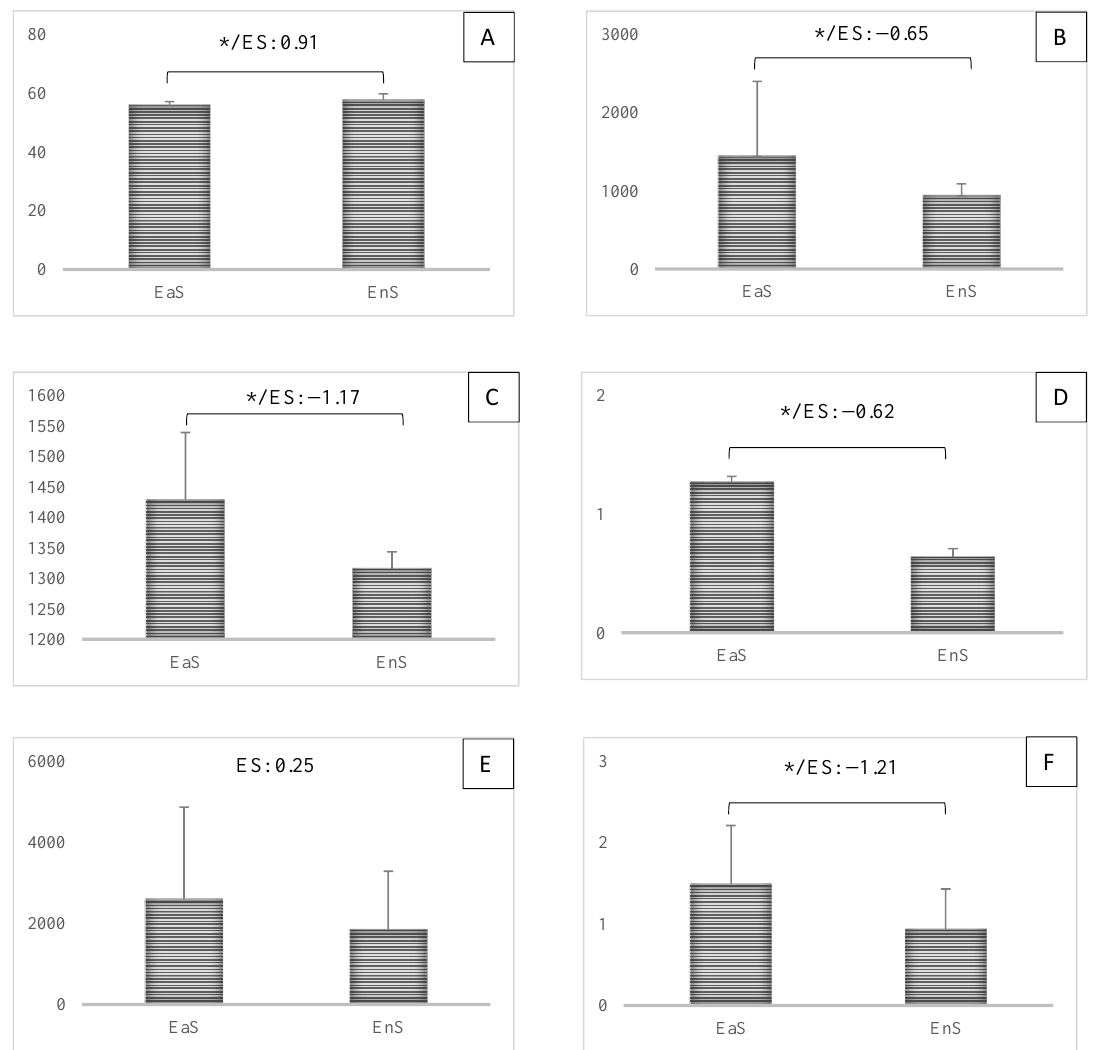
Figure 1. Comparison of 1st- and 2nd-half seasons in the workload parameters and aerobic power. ES: